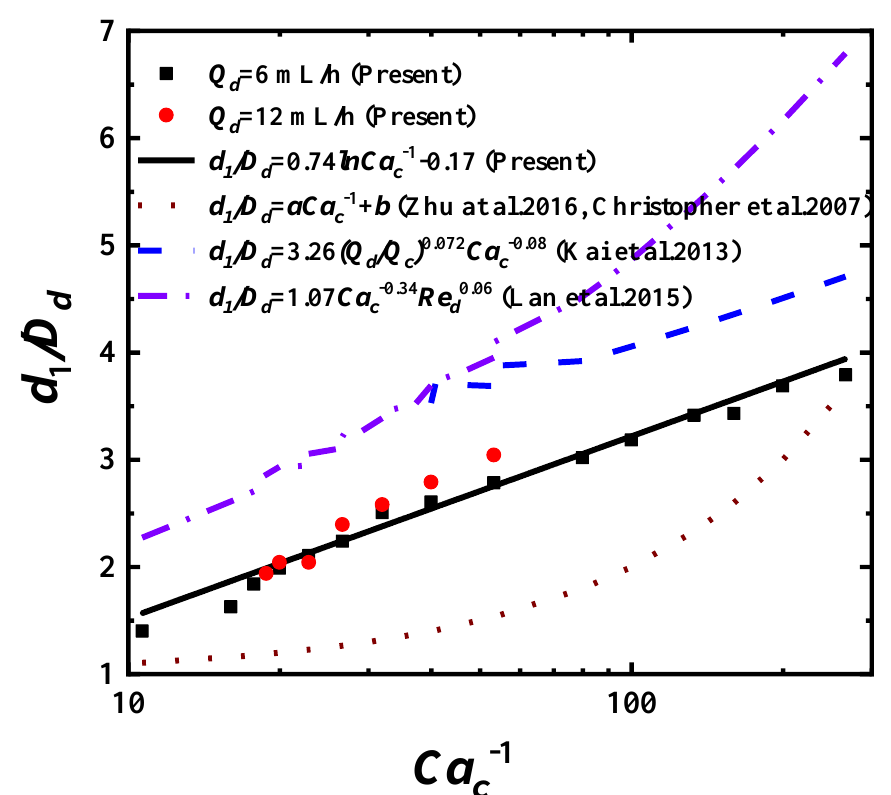
Figure 3. The normalized droplet diameter d 1 Ca − 1 c in the Dripping